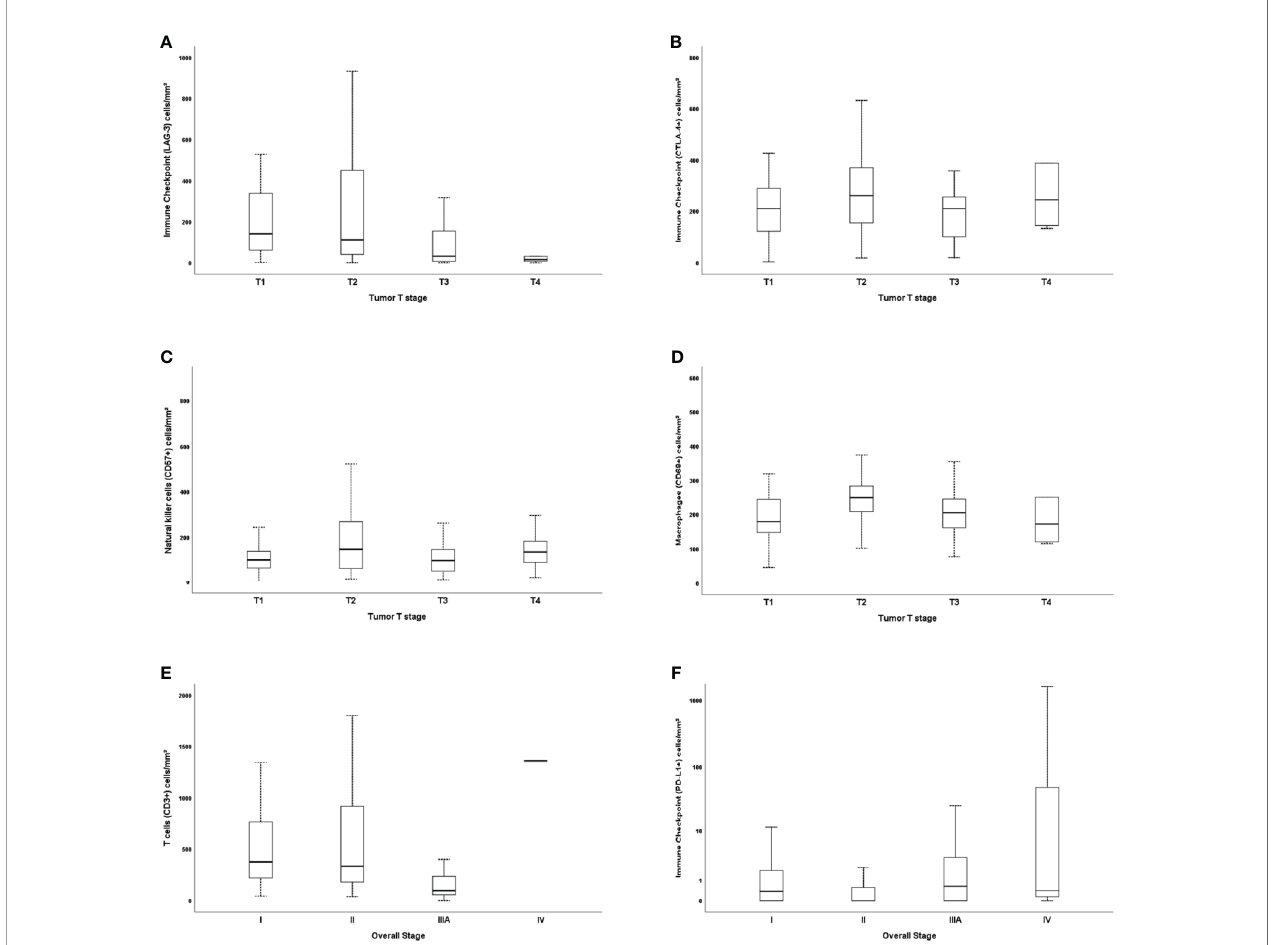
FIGURE 6 | Box plots demonstrating the relationshipsbetween immunostaining for immune cells, tumor T stage, and overallstage. LAG-3 and T stage (A) , CTLA-4+ and T stage (B) , natural killer cells CD57+ and T stage (C) , macrophages CD68+ andT stage (D) , and CD3+ and overall stage (E) , as well as PD-L1 (F) . The solid barsrepresent the number of immune cellsbetween the 25th and 75th percentiles; the black bar shows the median value; and thetop andbottombrackets show the extreme values.